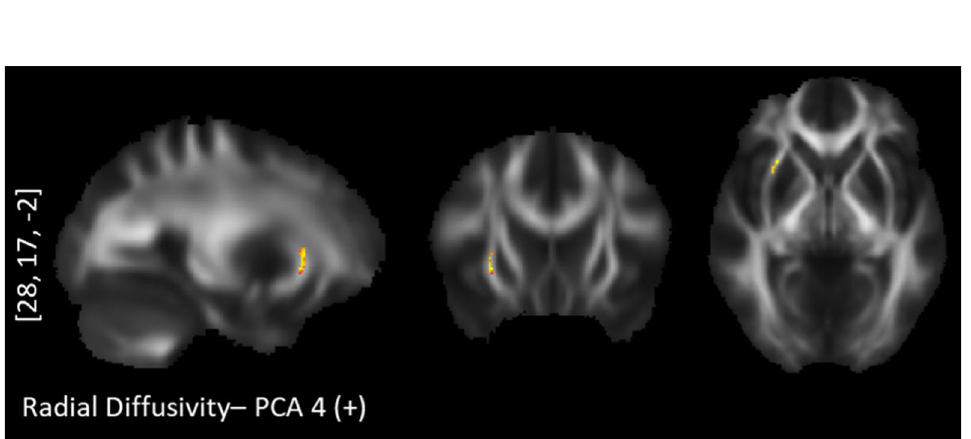
Figure 5. TBSS positive correlations between radial diffusivity and "Long-term approach behavor": right uncinate